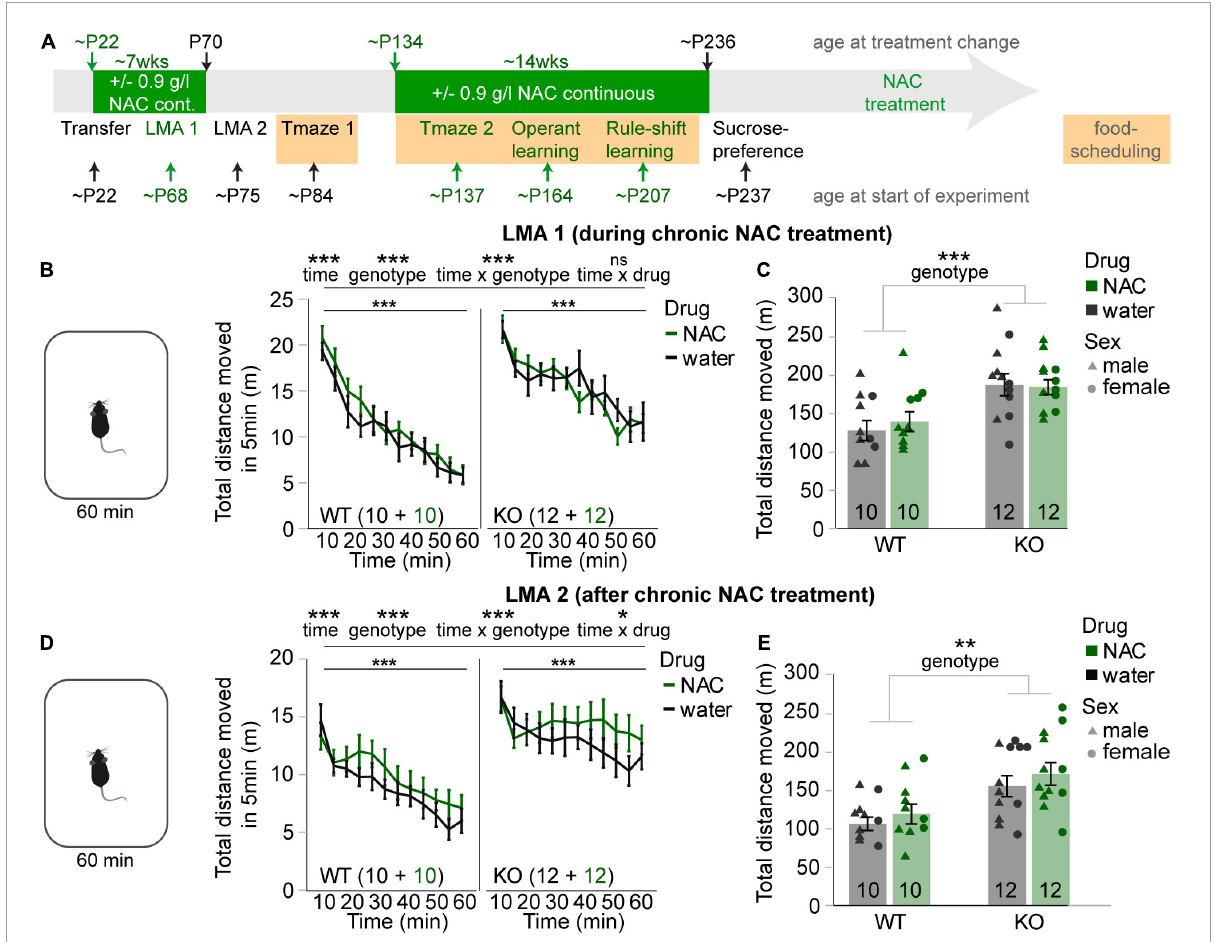
FIGURE1 N-acetylcysteine treatment does not affect novelty-induced hyperlocomotion in cyclin-D2 knockout mice. (A) Timeline of episodes of chronic NAC-treatment (green bars) and behavioral testing relative to the age of mice; episodes of food-deprivation are highlighted in orange. Tests that were done with NAC-treatment on the same day are in green font, tests without simultaneous NAC-treatment in black. Note that the second NAC-treatment was started 3 days before testing in the second T-maze experiments started and was stopped on the evening before the sucrose-preference test started. (B,D) Average distance moved over 60 min in the first (B) and second (D) novelty-induced locomotor activity (LMA) test displayed in 5 min bins for NAC-treated (green) and untreated (black) mice of the genotype indicated in the bottom left of each subpanel, also displaying n-numbers. Main effects and interactions from overall RM-ANOVA are indicated above panels; main effect of interval for RM-ANOVA within each subgroup indicated directly above data. No main effect of drug was found in either RM-ANOVA. (C,E) Same data and color-code as displayed in neighboring panels (B,D) but distance moved was summed up across time to allow univariate ANOVA, and data of individual animals is shown in addition, coded by treatment and sex; only a significant main effect of genotype was found. * p < 0.05; ** p < 0.01; *** p < 0.001. Error bars,